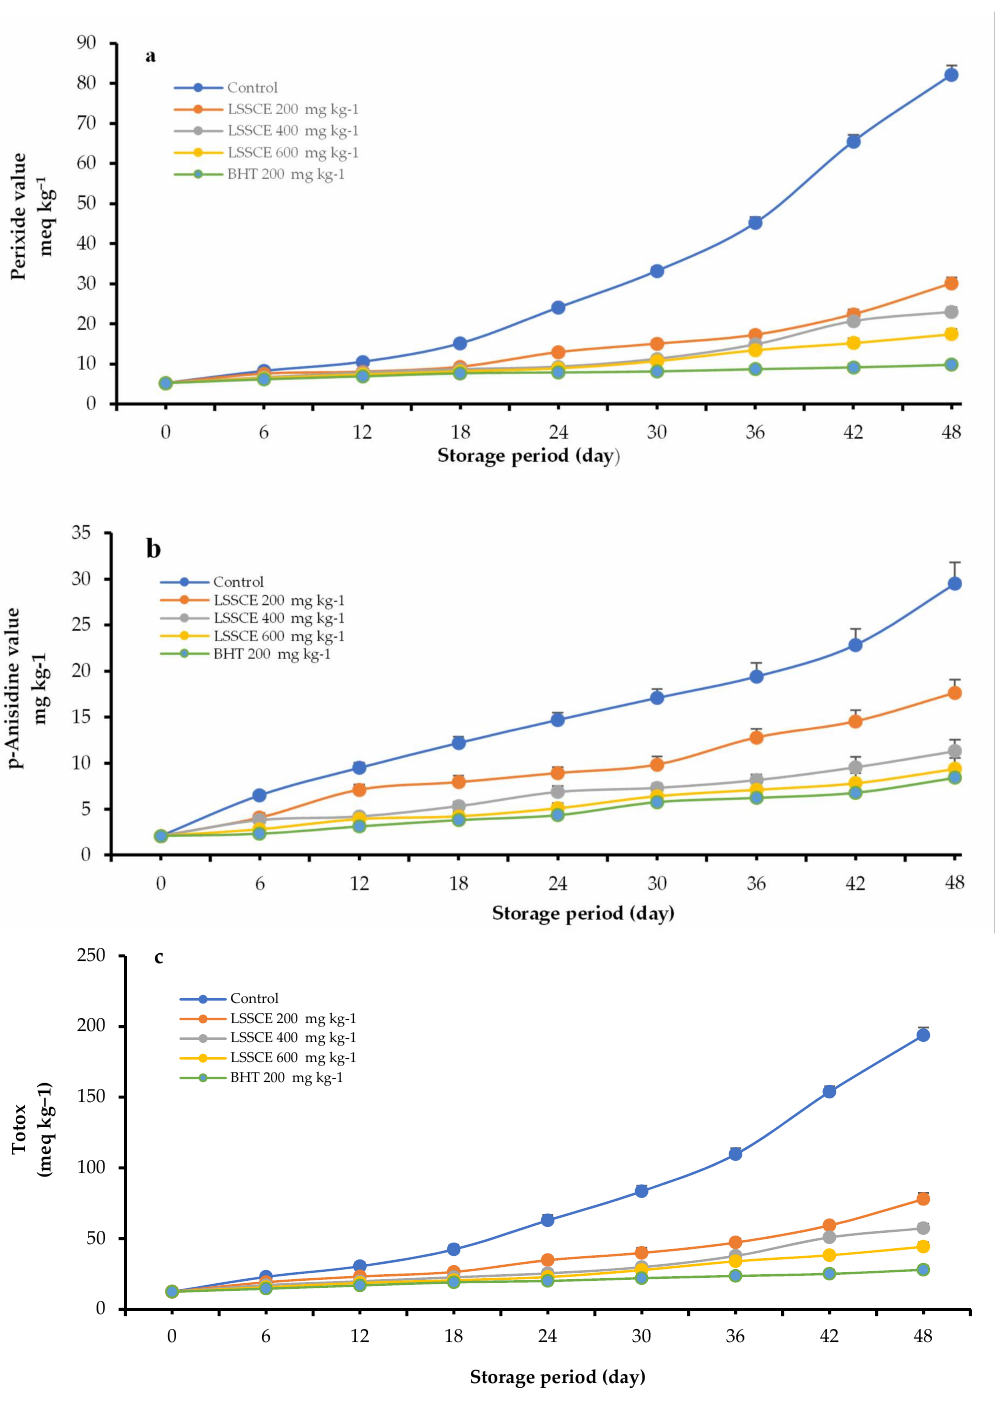
Figure 2. Impact of LSSCE on peroxide value ( a ), p-anisidine value ( b ), and totox value ( c ) in ROO stored at 60 °C.